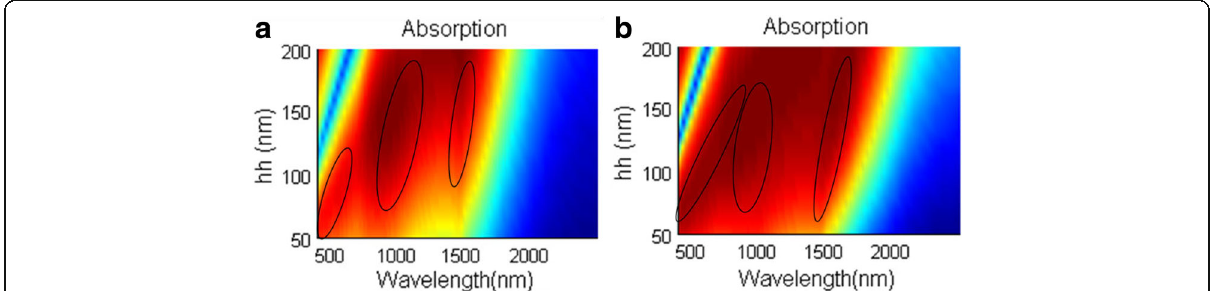
Fig. 9 Absorbing spectra of the three-layer FMA as a hd = 20 nm and b hd = 10 nm varying with dielectric thickness hh. Black circles mark resonance peaks